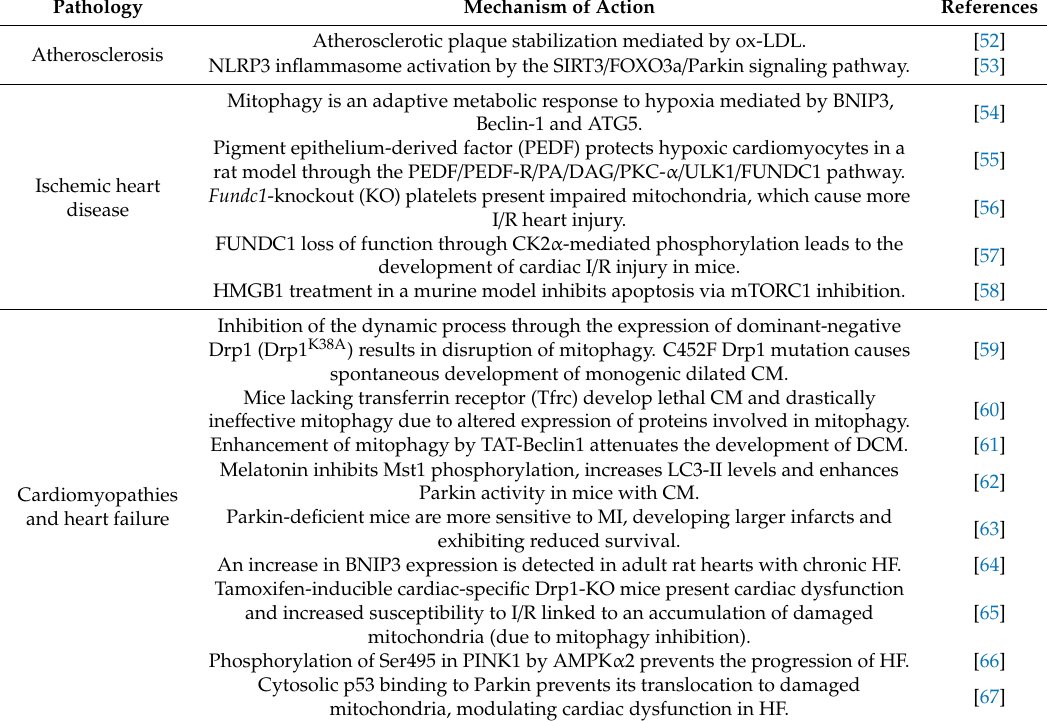
Table 1. Summary of literature describing mitophagic pathways in cardiovascular